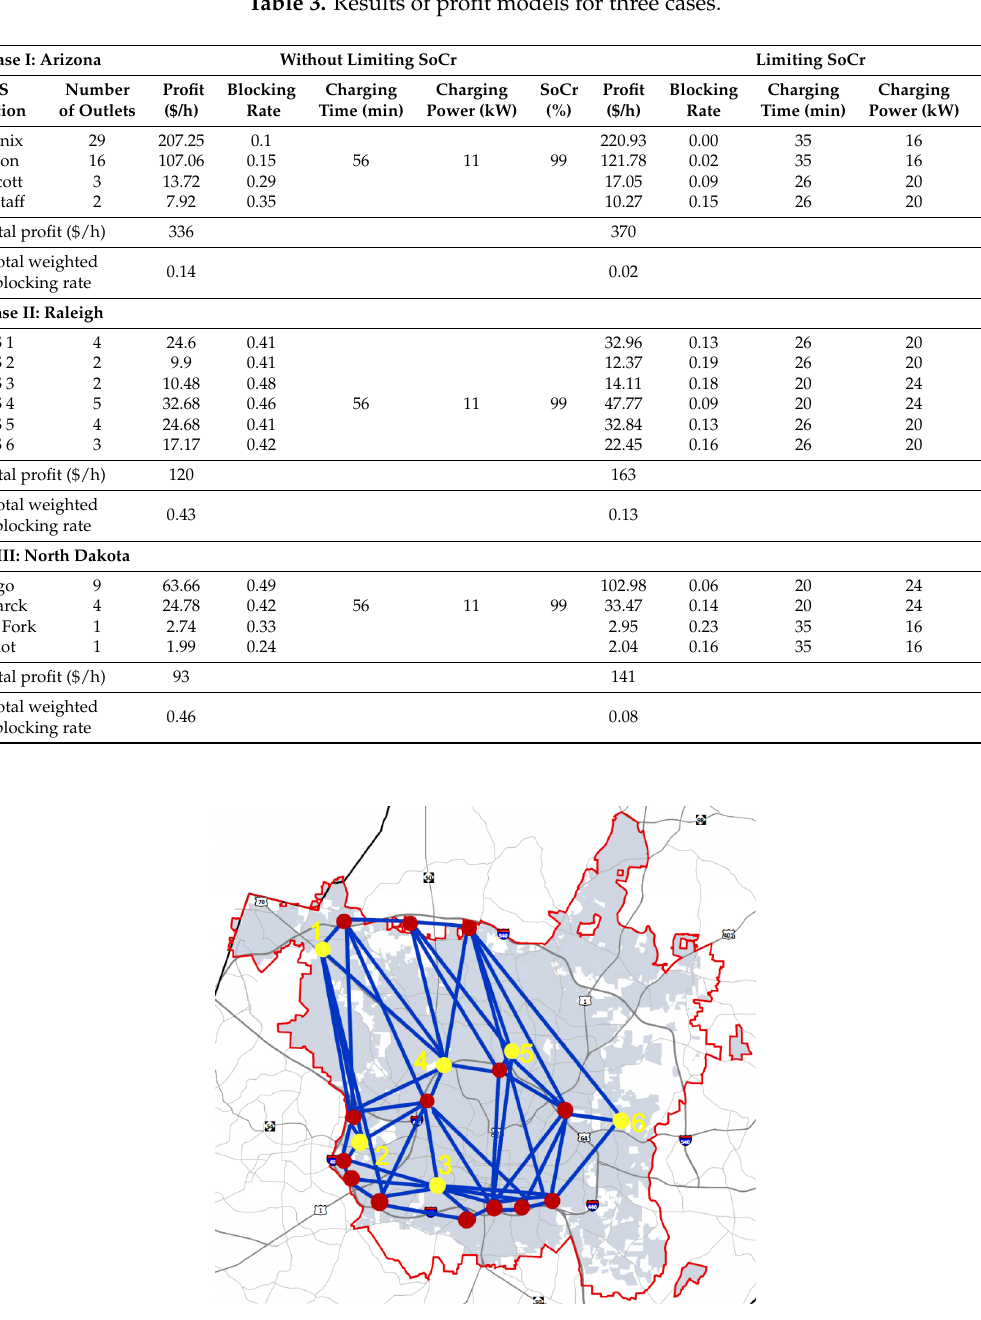
Table 3. Results of profit models for three cases.